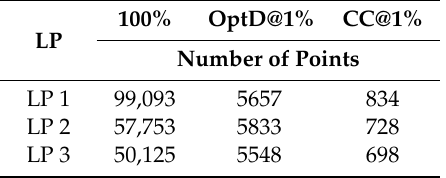
Table 5. Effect of data reduction on points far from LPs.